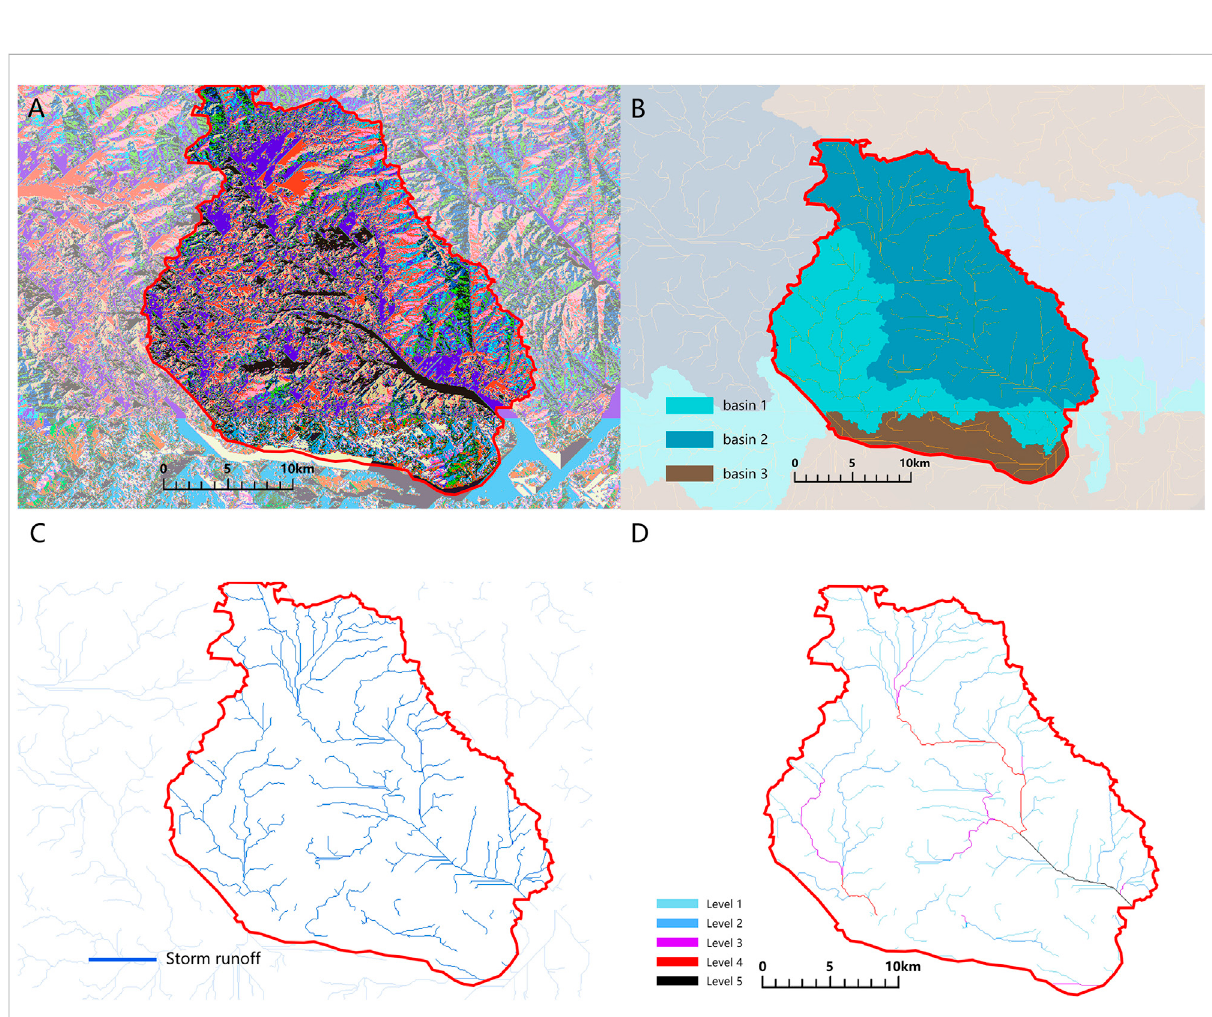
FIGURE 4 Hydrological analysis in the study area. (A) Flow direction, (B) drainage basin, (C) storm runoff, and (D) storm network classi fi cation.